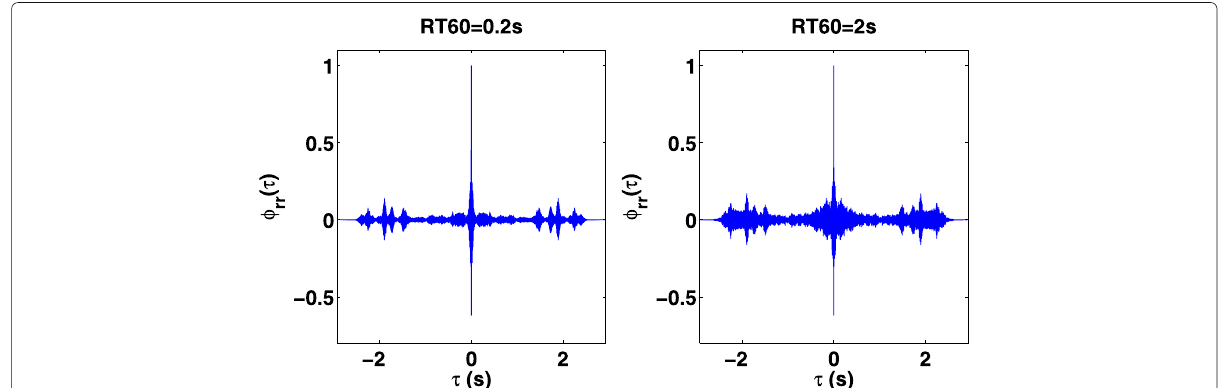
Fig. 4 Temporal auto-correlation function of an utterance in TIMIT dataset [51], corrupted by reverberation at RT60 = 0.2 and 2 s,